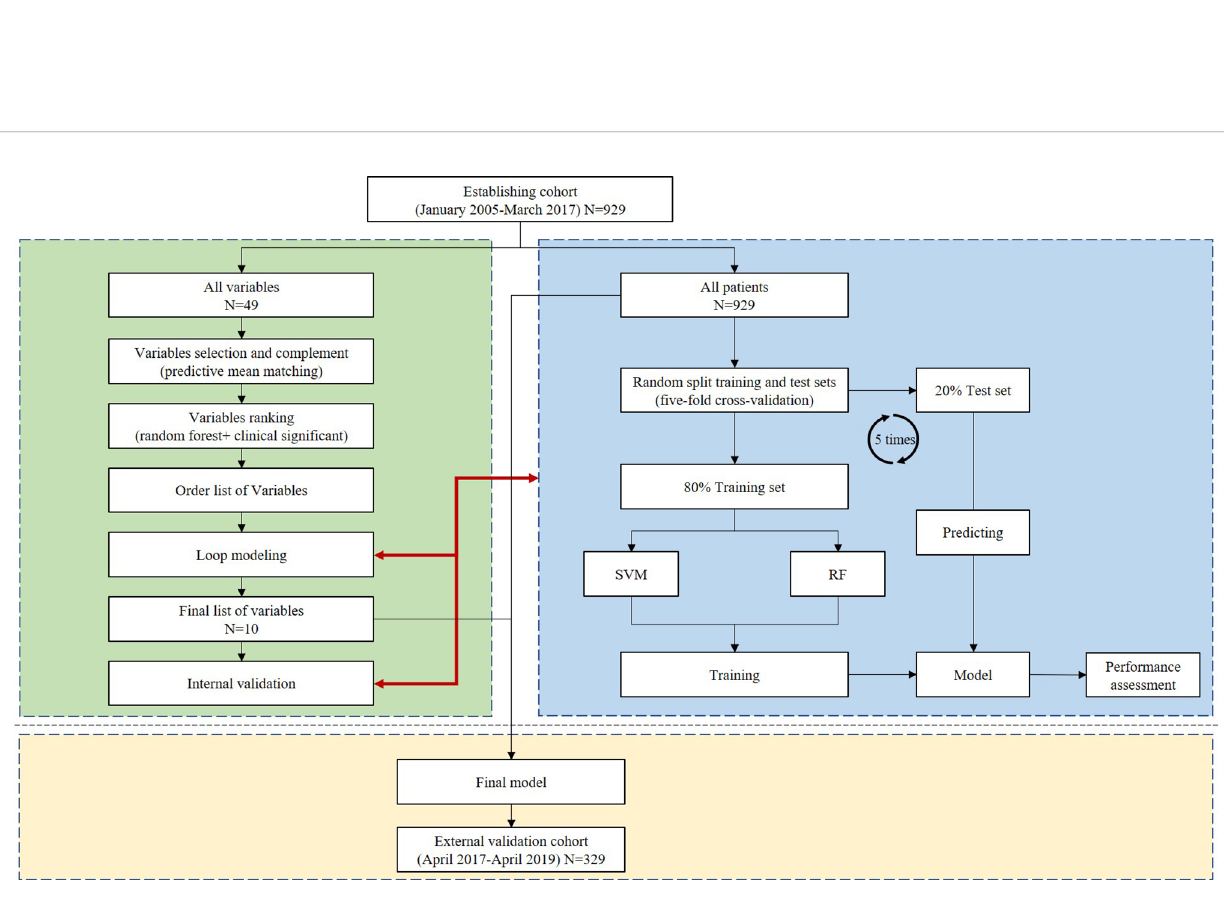
FIGURE 2 | Analysis fl ow for the development and evaluation of the models.